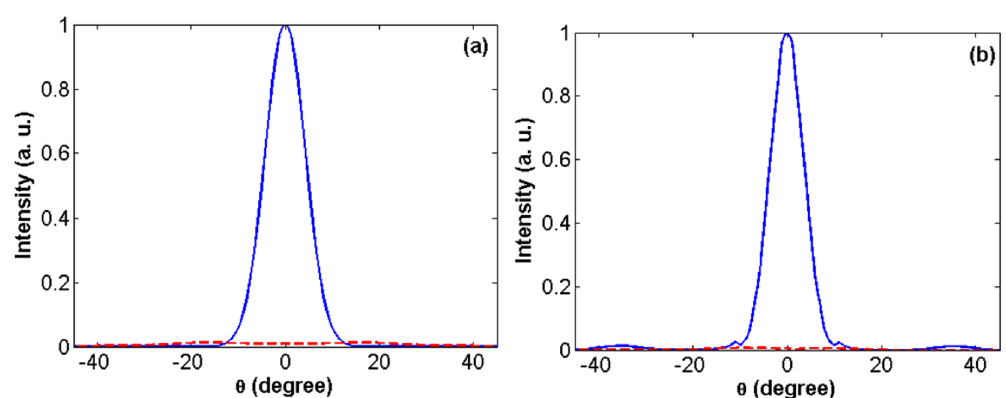
Figure 4. Dashed-red and solid-blue curves in panel (a) and (b), respectively, represents the calculated and measured far-field angular radiation patterns of the bare aperture and ZIM / A / ZIM hybrid structure, at f = 12.75 GHz